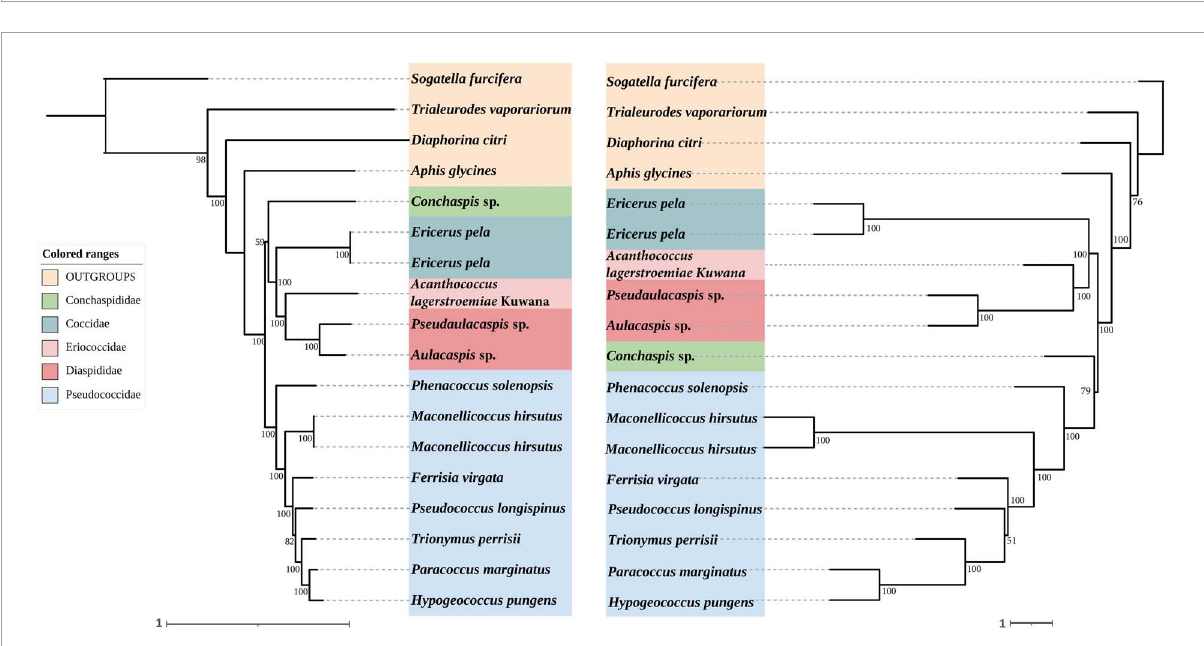
FIGURE4 Left: Concatenated tree of 95% completeness matrices from Coccoidea probe set. Node values are bootstrap support. Right: Species tree of 95% completeness matrices from Coccoidea probe set. Node values are bootstrap support.